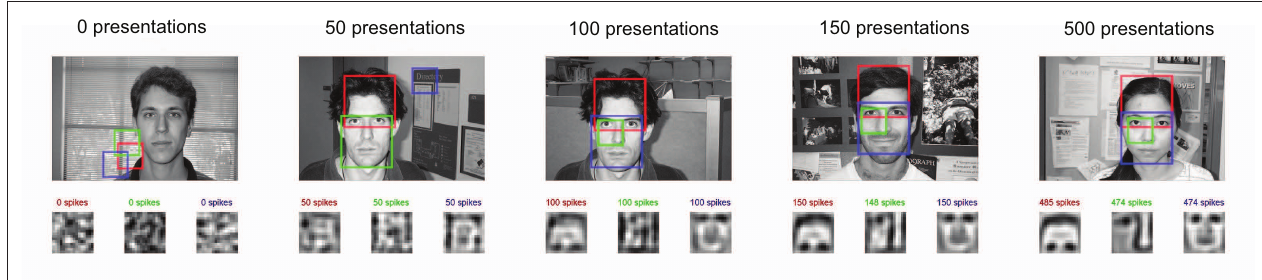
Figure 2 | Preferred stimulus reconstructions of three C2 cells after 0, 50, 150, and 500 presentations. At the top of each frame, the input image is shown with red, green, or blue squares, indicating the receptive fields of the cells that fired (if any). At the bottom, we reconstructed the preferred stimuli of the three cells: the left cell gradually becomes selective to foreheads, the middle